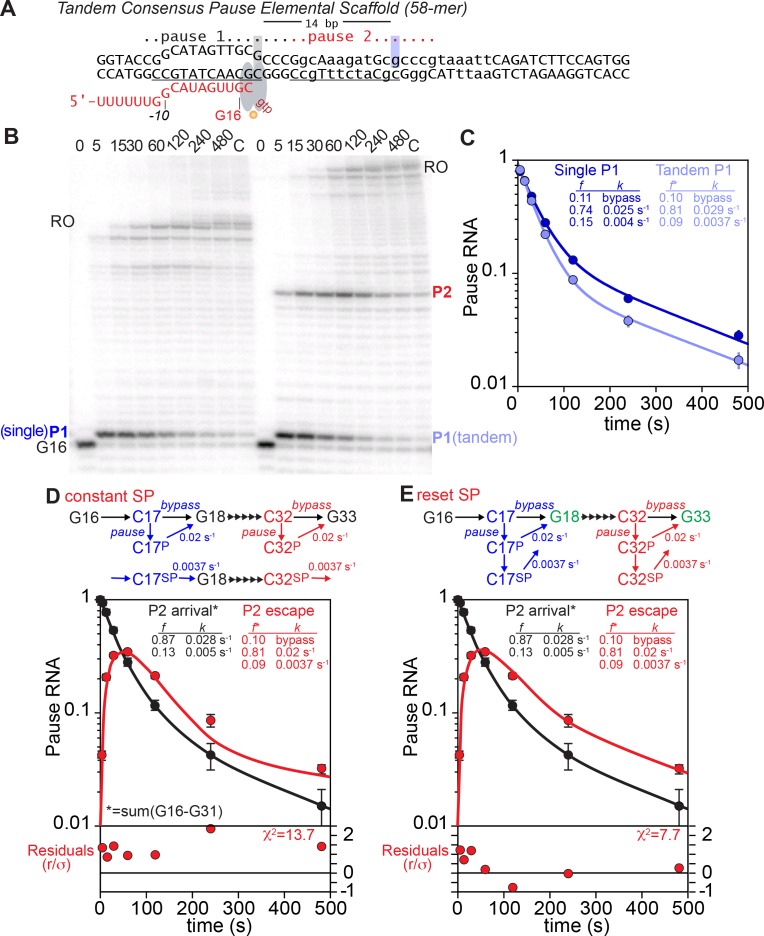
(A) Scaffold used to probe for biphasic escape kinetics at two sequential elemental pause sites (Tandem Consensus Elemental Pause Scaffold; tDNA #12623, ntDNA #12624, RNA #8342; Supplementary file 1).(B) Pause assays on single or tandem consensus pause scaffold (Single Pause; left time course) or Tandem Pause Scaffold (right time course). Transcription was initiated by addition of NTPs to 100 µM each ATP, UTP, and CTP, and 10 µM GTP. The gel image is representative of triplicate assays. (C) Quantitation of the C17 pause band (P1) on the single or tandem pause scaffold. (D) Tandem scaffold pause P2 fit to a kinetic model with a single pause species (constant EC fraction in slow pause, SP, state). The fit was calculated by first modeling the arrival of ECs at the second pause, plotted as escape from the region before the pause (red line). This flux of ECs arriving at the second pause was subjected to least-squares fitting using numerical integration to a model of pausing involving only a single pause species. Residuals show the difference between the actual and predicted P2 pause RNA amounts. (E) Tandem scaffold pause P2 fit to a kinetic model with two pause species (EC resets so SP reforms at second site). Fitting was conducted as described for panel E, except the pause model included two pause species, with a slow pause arising from the faster pause.